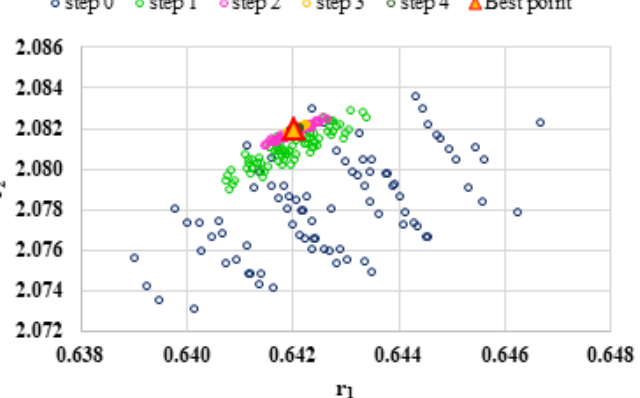
Figure 3. Distribution of P cen (r 1 , r 2 ) points for each step of searching for the k-NN method for the conditions imposed by LC3.